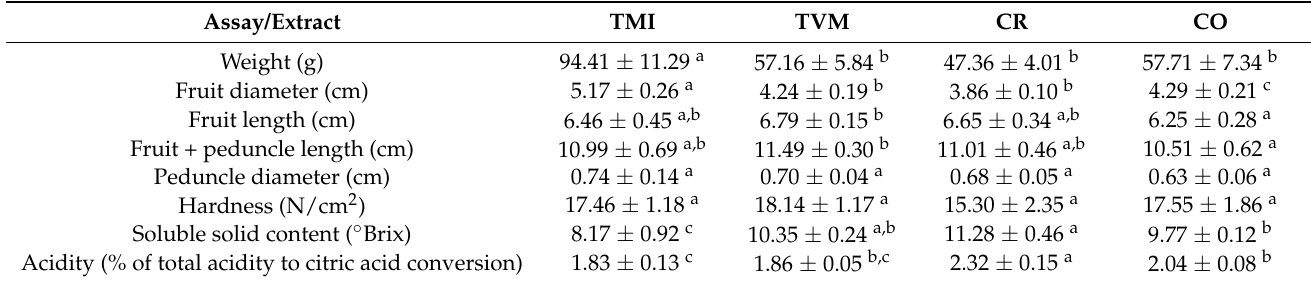
Figure 1. Tamarillo fruits: ( A ) TMI (red) from Colombia; ( B ) TVM (red) from Mealhada; ( C ) CR (red) from the Botanical Garden of Coimbra; ( D ) CO (orange) from the Botanical Garden of Coimbra. Table 1. Physical properties of the tamarillo genotypes of the present study.